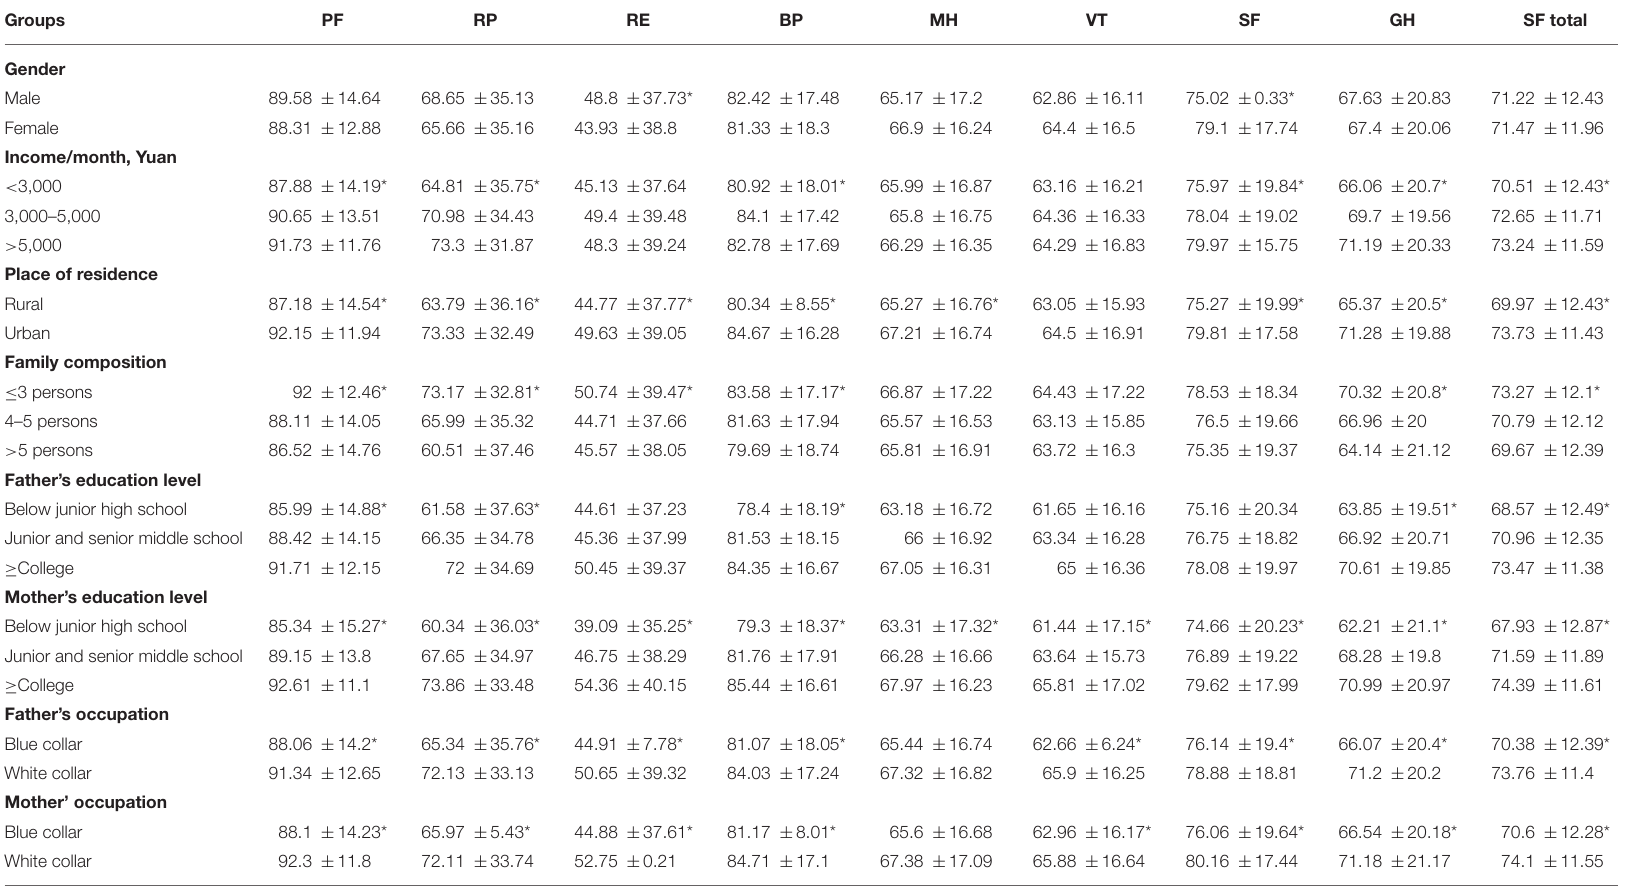
TABLE 5 | The scores of each subscale of quality of life and their differences in social and economic characteristics ( x ± s ).